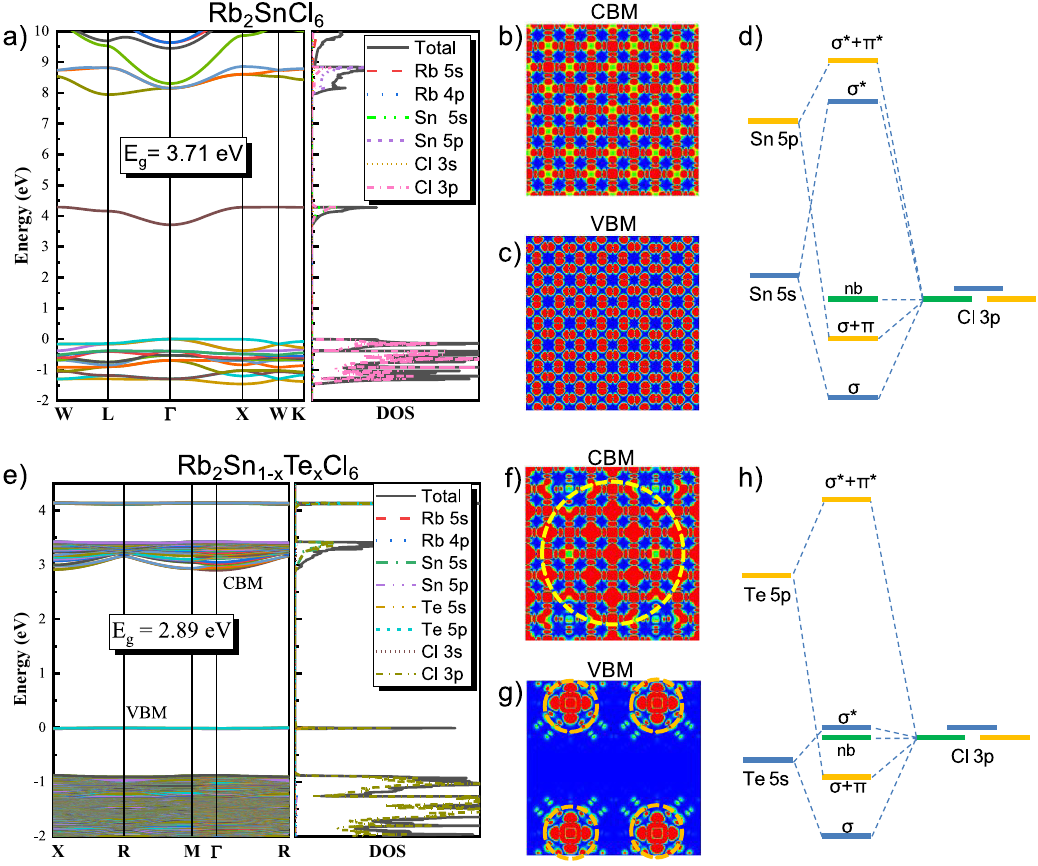
Figure 4: Theoretical calculation results of Rb 2 SnCl 6 (a – d) and Rb 2 Sn 1 − x Te x Cl 6 (e – h). (a, e) Band structures and density of states. (b, f) Charge density isosurface of CBM. (c, g) Charge density isosurface of VBM. (d, h) Simpli fi ed molecular orbital